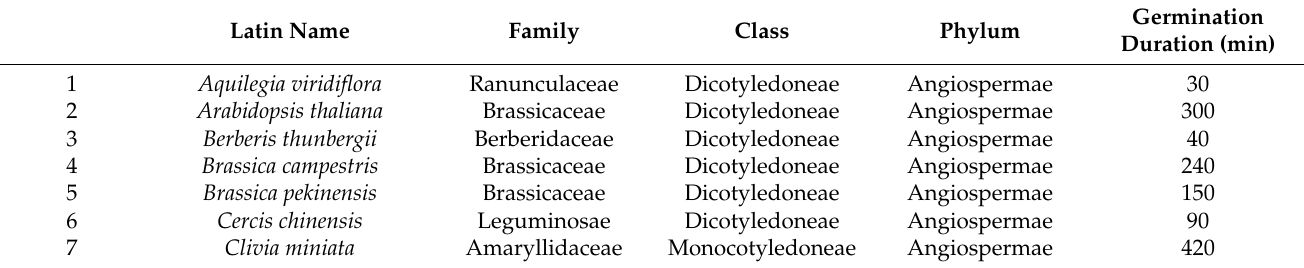
Figure 1. ATP-regulated PG and PTG in various plant species. Pollen grains of 34 plant species were germinated in vitro in the medium containing 18% sucrose, 0.1 mM KCl, and 0.5% agarose. Germination duration of each species is listed in Table 1. PG ( A ) and PTG ( B ) were noted. In each experiment, at least 300 pollen grains or 150 pollen tubes were counted or measured. Data from 3 replicates were calculated to obtain mean ± SD. Student’s t -test p values: * p < 0.05, ** p < 0.01. Table 1. Plant materials for in vitro pollen germination (sorted by the initials of the Latin names of plant species). Latin